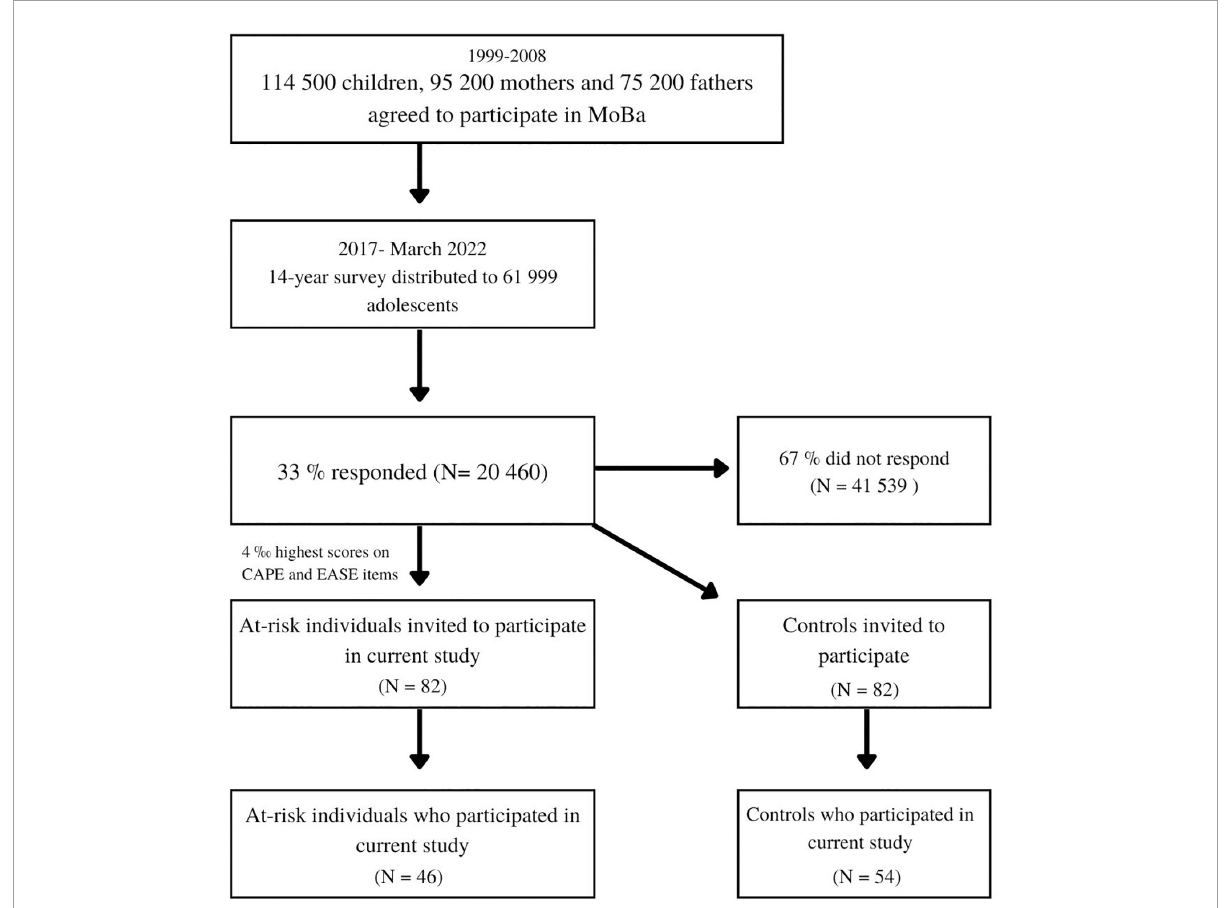
FIGURE1 Flowchart of